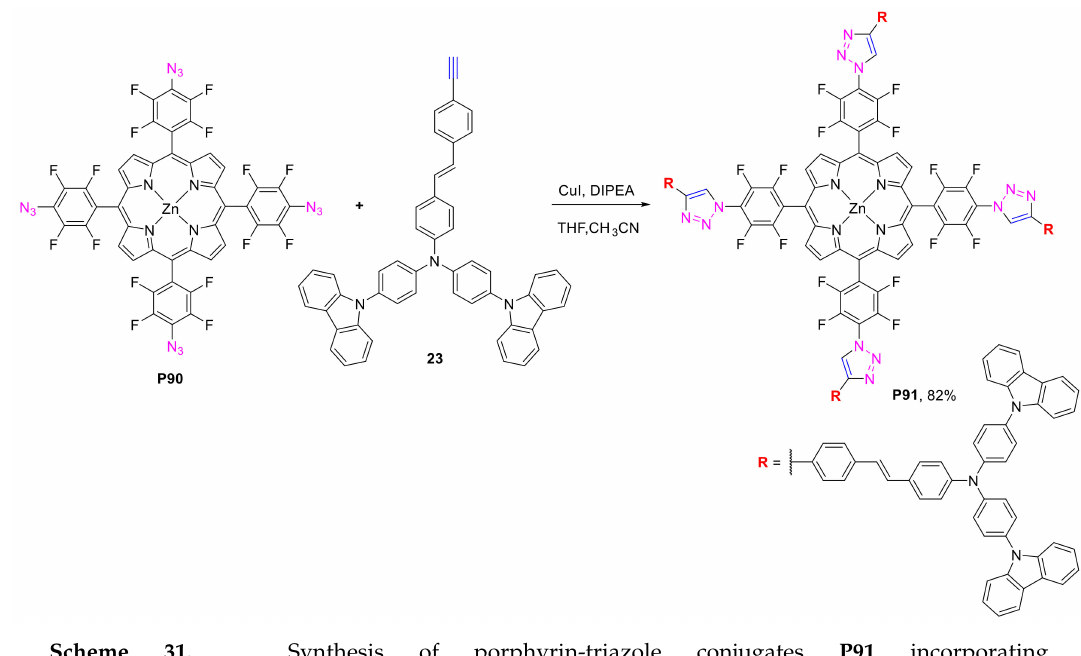
Scheme 31. Synthesis of porphyrin-triazole conjugates P91 incorporating bis(carbazolyl)triphenylamine